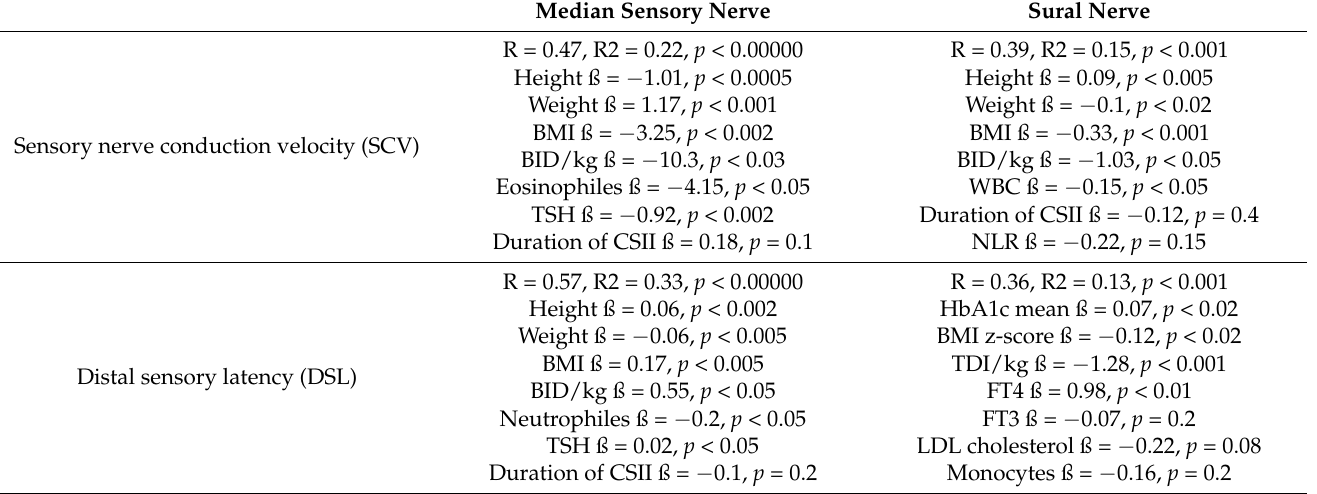
Table 2. Multiple regression models for nerve conduction studies of sensory